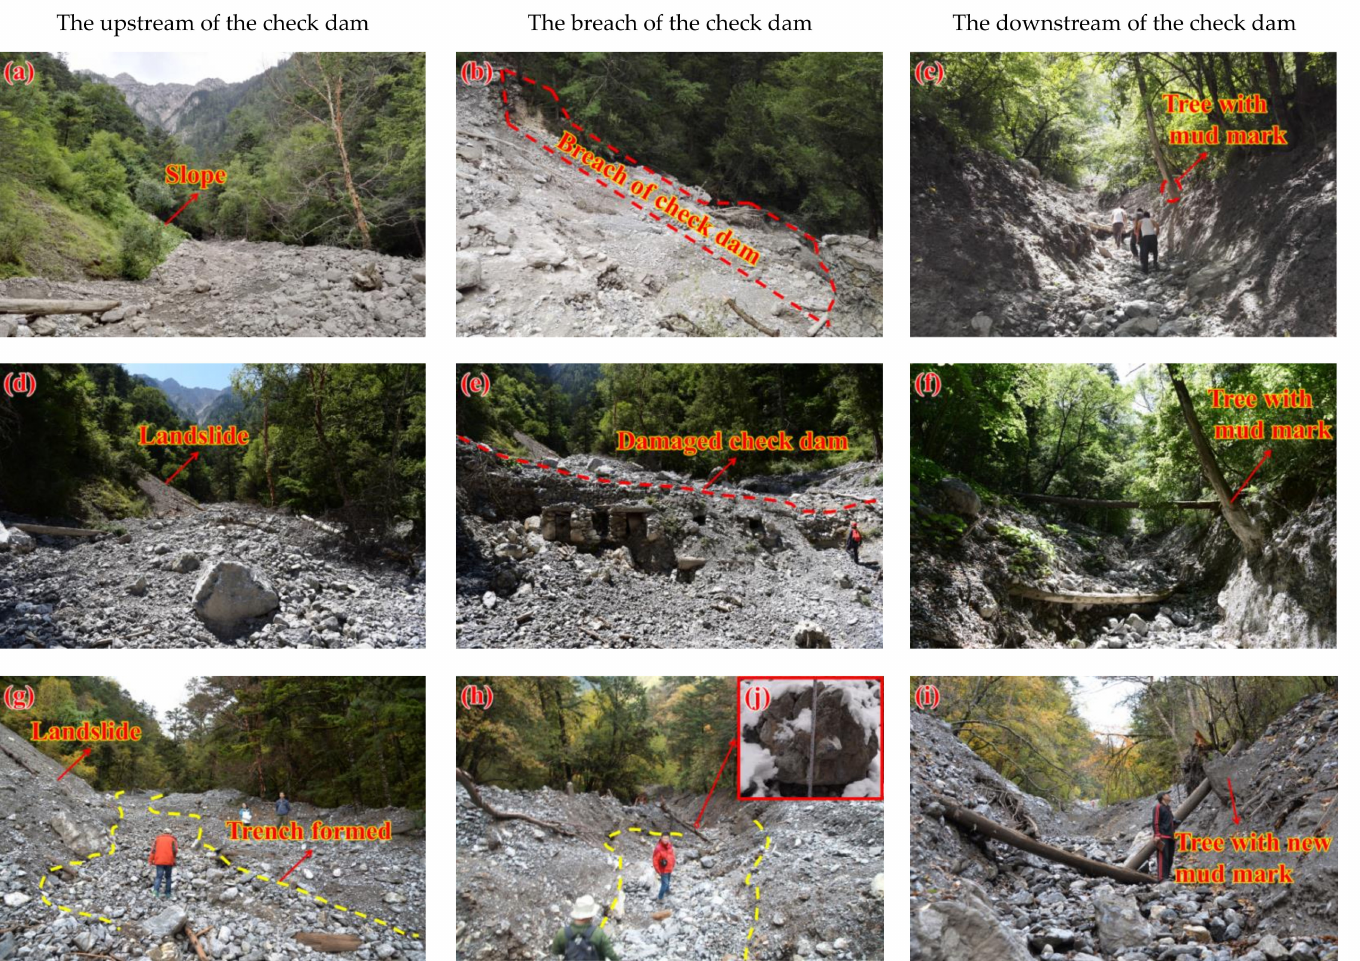
Figure 3. Images of Zechawa Gully debris flow in di ff erent periods: ( a )–( c ) 6 August 2016, ( d )–( f ) 16 August 2017, ( g )–( i ) 23 October 2017; ( j ) large boulder transported by the debris flow that occurred in September